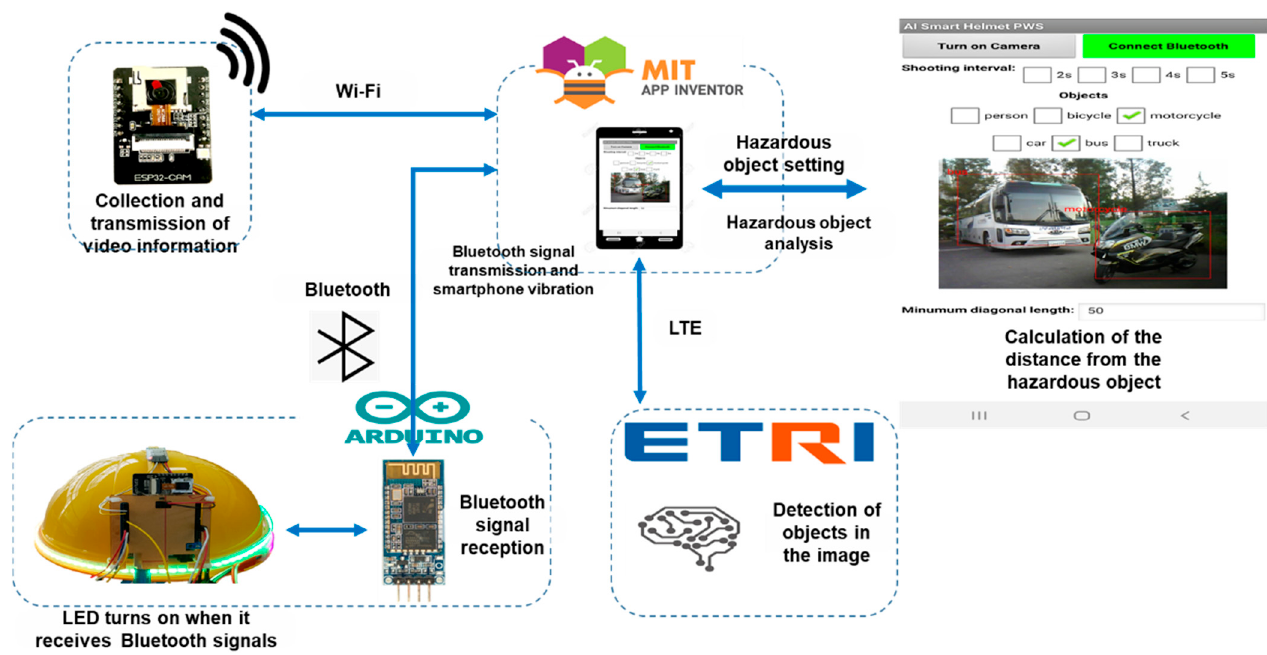
Figure 10. Conceptual diagram of the AI smart helmet-based PWS.